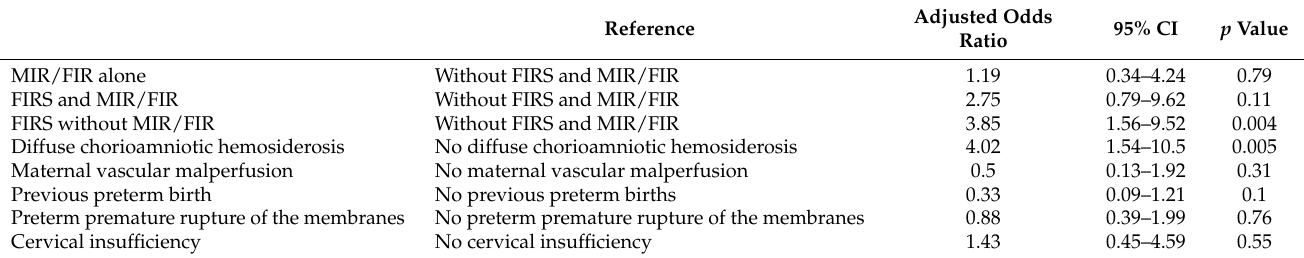
Table 6. Multivariate logistic regression analysis of the presence of extremely low gestational